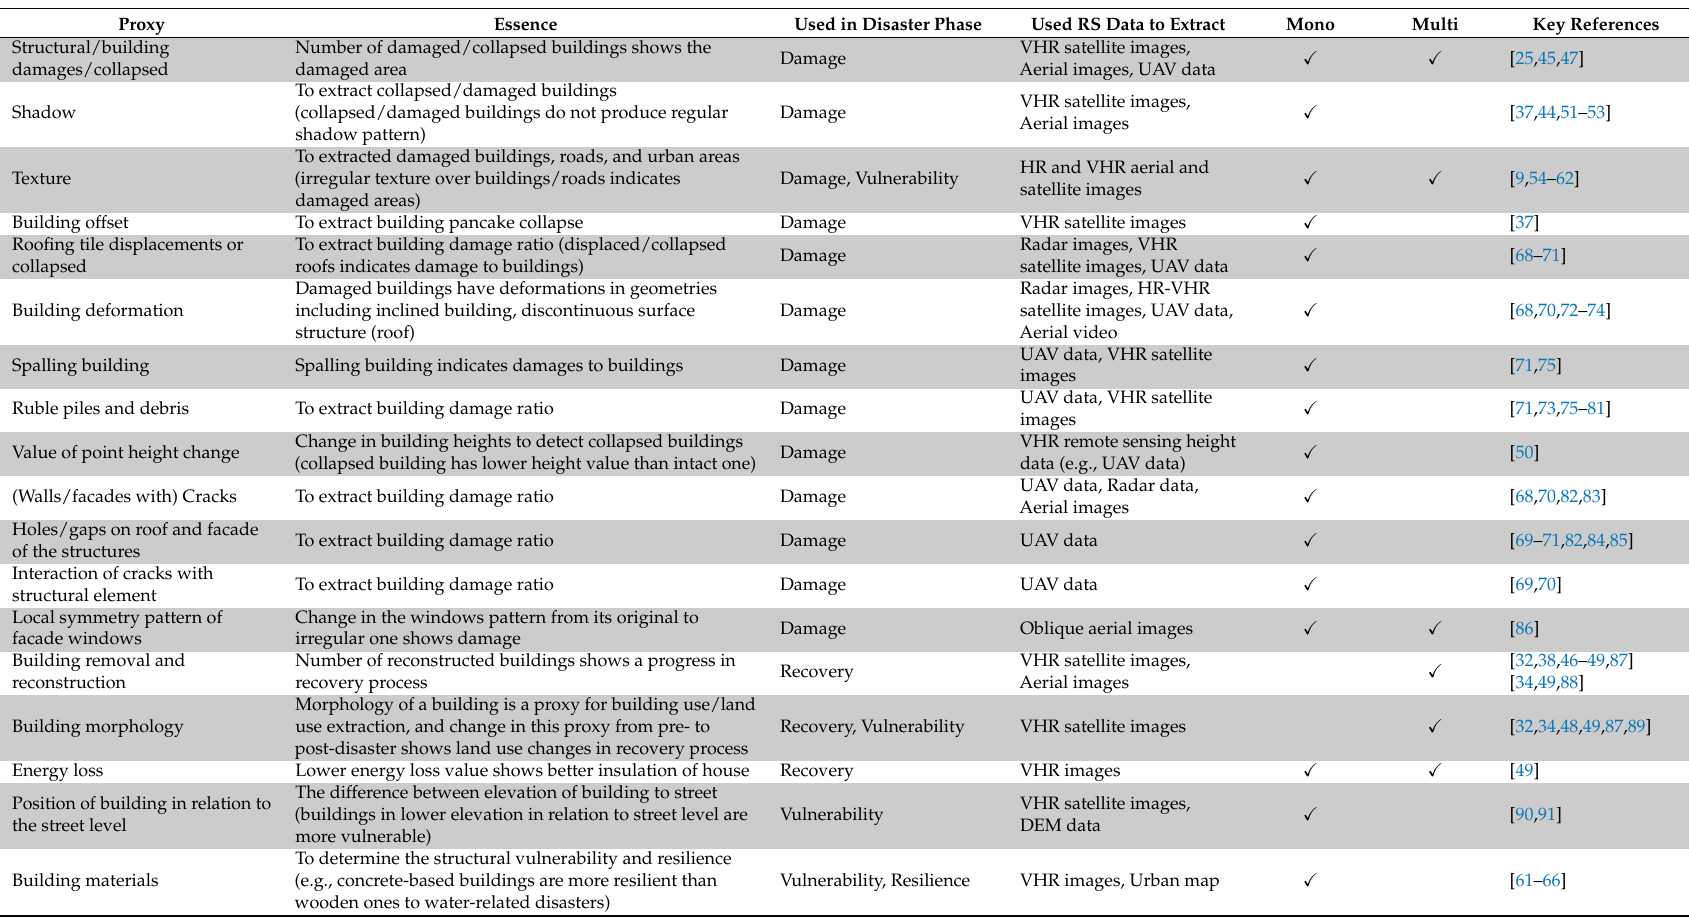
Table 1. Remote sensing-based built-up proxies for urban DRM, Buildings category. Mono and Multi refer to mono-temporal and multi-temporal remote sensing (RS) data that are used for the extraction,